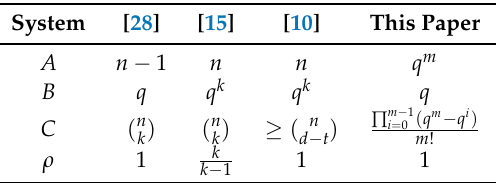
Table 1. Comparison with other